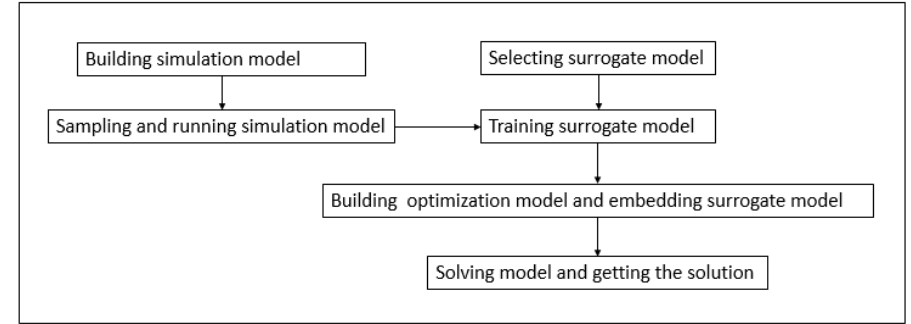
Figure 1. The workflow of the model connection process.